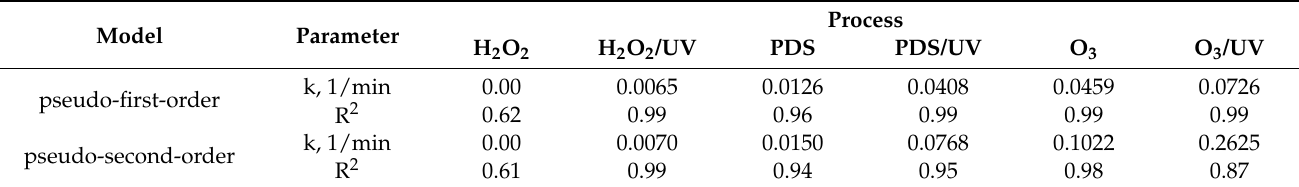
Table 2. Kinetic parameters of the advanced oxidation process.